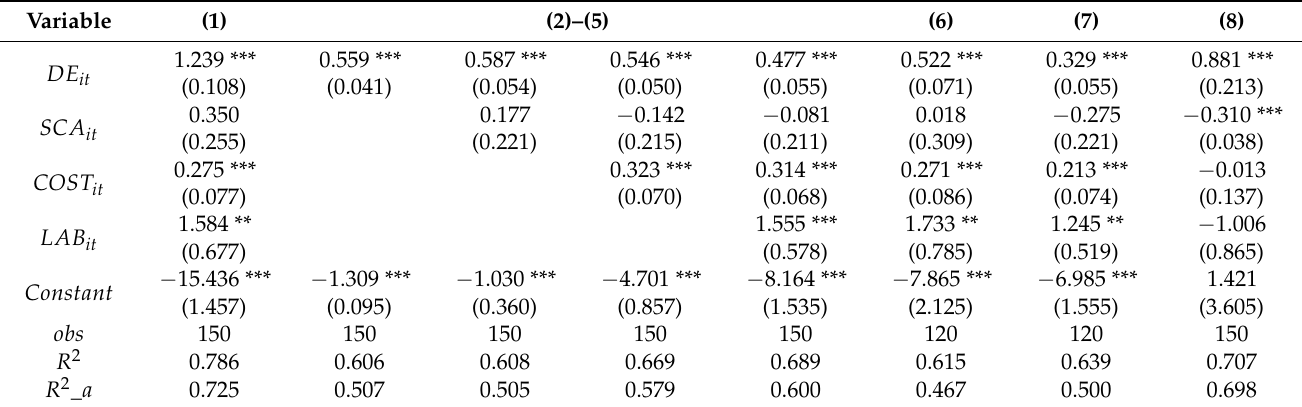
Table 10. Robustness test